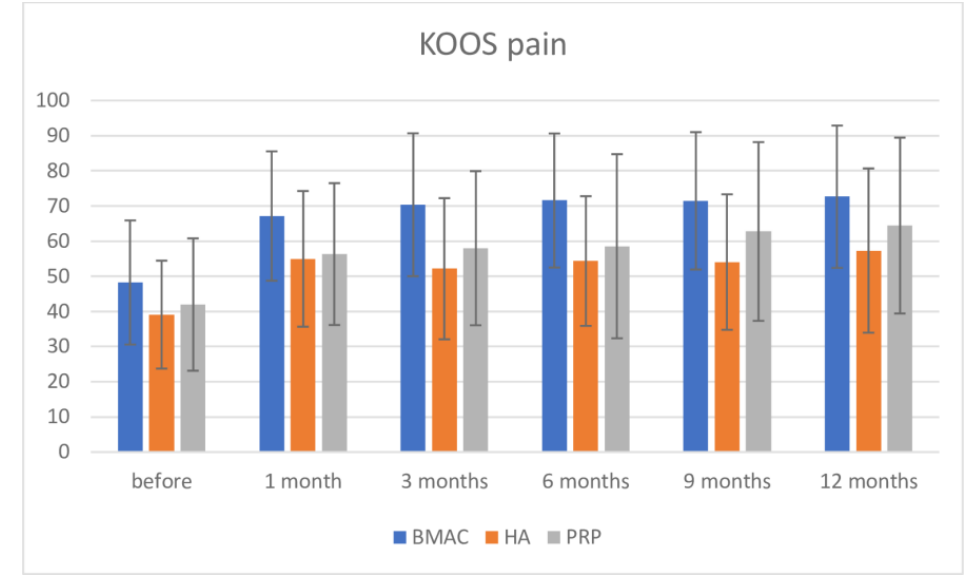
Figure 4. KOOS pain scale before intervention and after 1, 3, 6, 9, and 12 months.